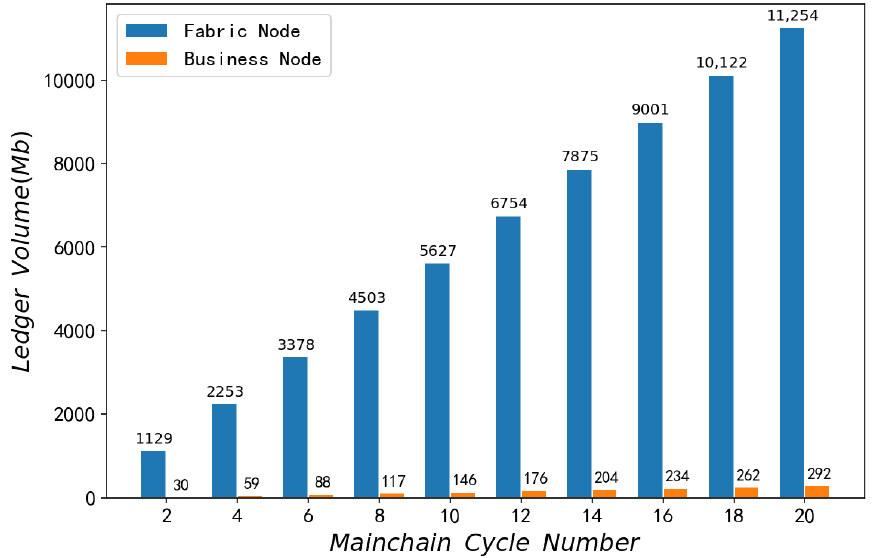
Figure 10. Comparison of the ledger data volume (single world state creation transactions).